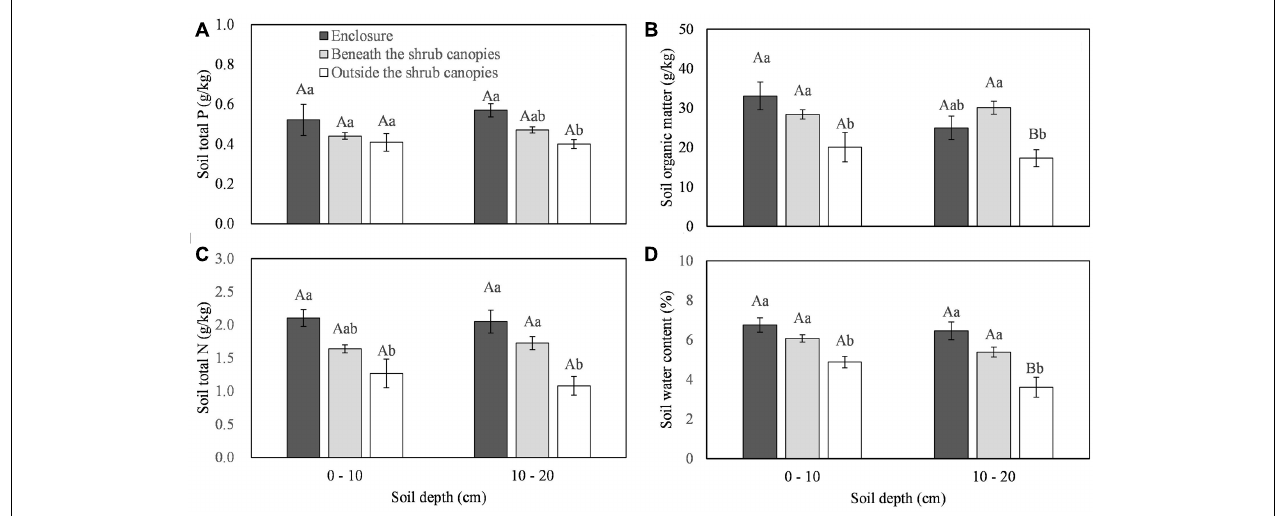
FIGURE 1 | Effects of the sampling sites (enclosure, beneath the shrub canopies, and outside the shrub canopies) on the soil total P (A) , soil organic matter (B) , soil total N (C) and soil water content (D) in different soil layers. Different capital letters indicate a significant difference between the 0–10 cm and 10–20 cm soil layers, and different lowercase letters indicate a significant difference among the three sampling sites at P < 0.05.